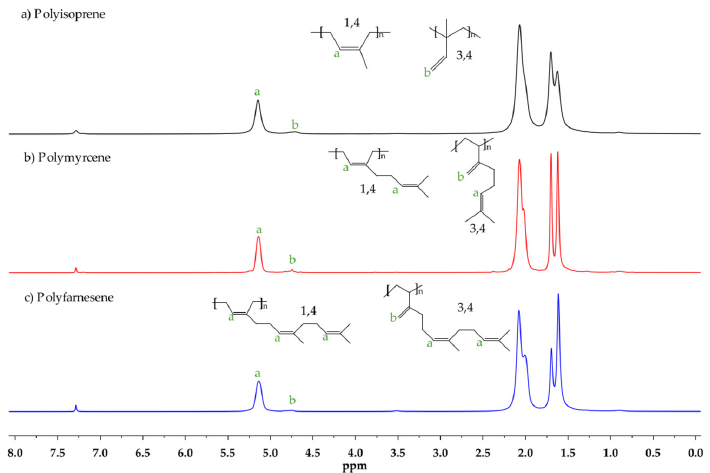
Figure 3. 1 H NMR spectra using CDCl 3 as solvent on ( a ) Ip: entry Ip-11, ( b ) My: entry My-11, and ( c ) Fa: entry Fa-15.